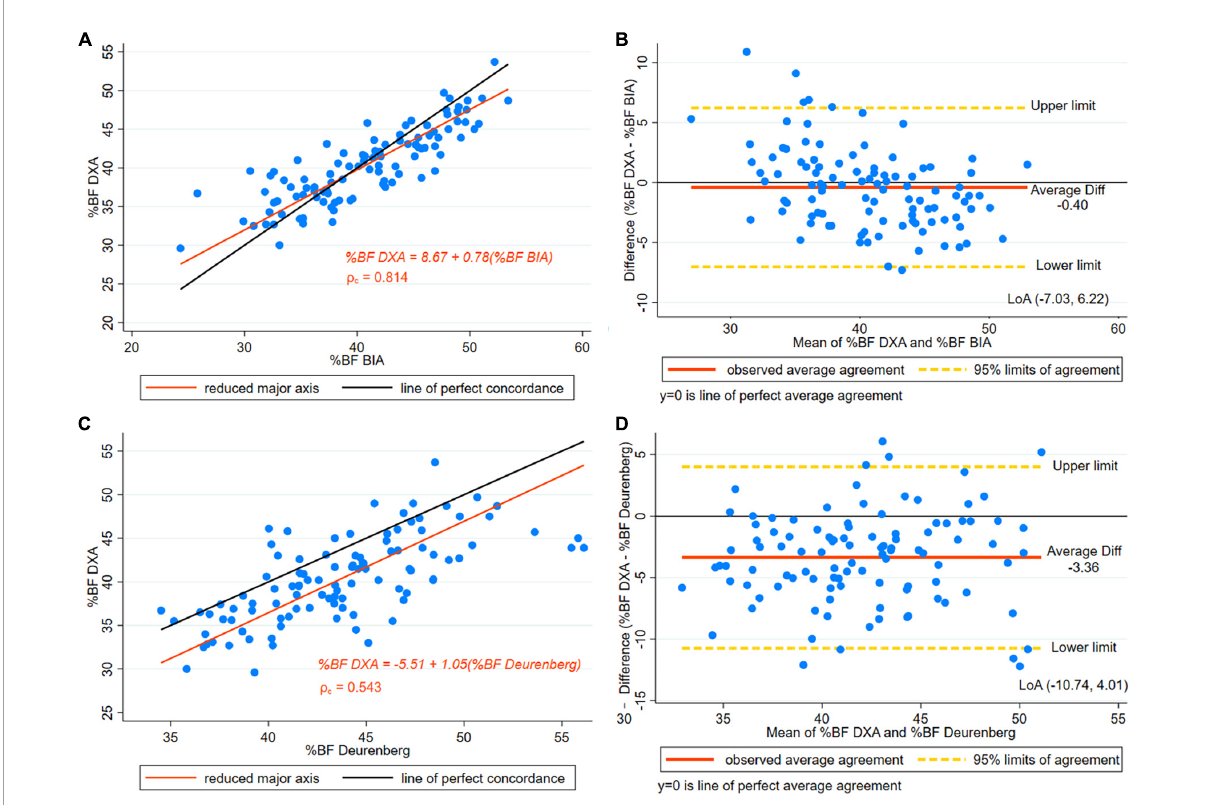
FIGURE2 (A) Concordance plot of body fat percentage (BF%) estimated by DXA and MF-BIA (multi -frequency InBody 720 equipment). Pearson’s correlation coefficient (r) and Lin’s concordance correlation coefficient ( ρ c ) for women with height > 145 cm. (B) The Bland-Altman plot is presented along with the Limits of Agreement (LoA) of BF% estimated by DXA and MF-BIA (Multi -Frequency BIA InBody 720) for women with height > 145 cm. (C) Concordance plot for BF% estimated by DXA and Deurenberg’s equation in women with height > 145 cm. (D) The Bland-Altman plot is presented along with the LoA for BF% estimated by DXA and Deurenberg’s equation in women with height > 145